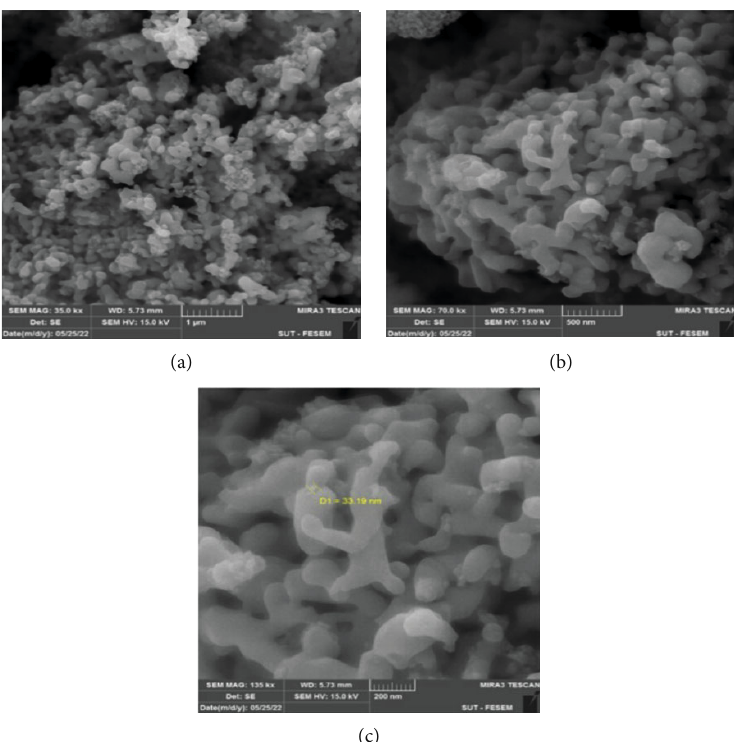
Figure 2: Alumina after coating with pvp polymer with di ff erent magni fi cations (a) with 1 μ m magni fi cation, (b) with 500 nm magni fi cation, (c) with 200nm magni fi cation.